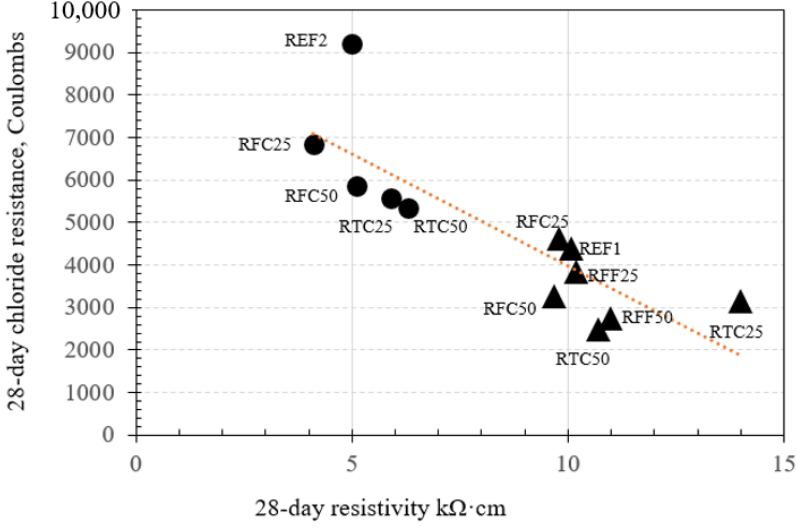
Figure 9. Relationship between rapid chloride resistance and resistivity of concretes at 28 days ( ▲ = w/c ratio 0.25; ● = w/c ratio 0.5).